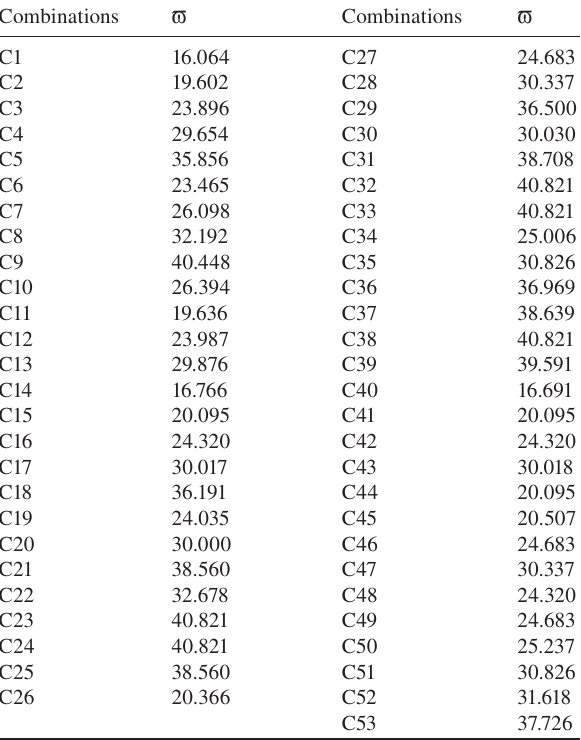
Table 3 Fundamental frequency parameter for laminated plates with two intermediate line supports for ( SSSS ) boundary condition.